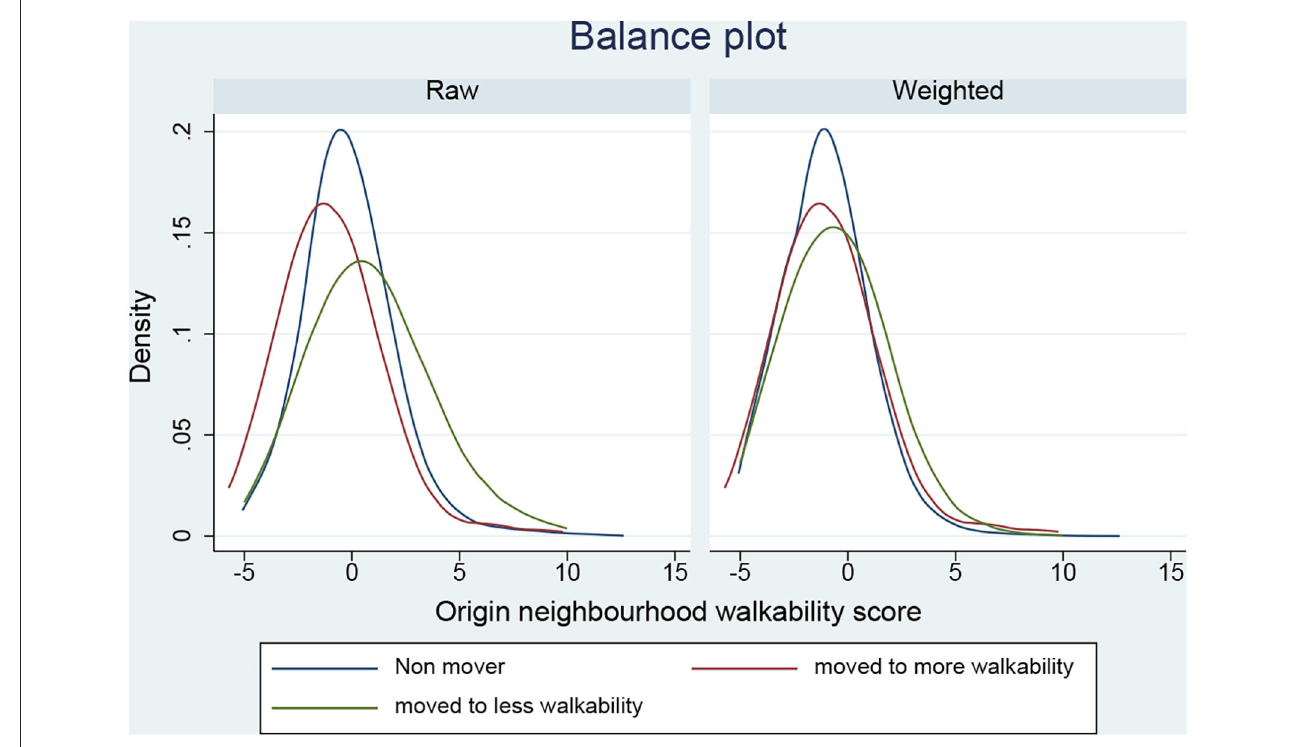
FIGURE1 Balance in origin neighborhood walkability scores between residential relocation status groups before and after weighting.